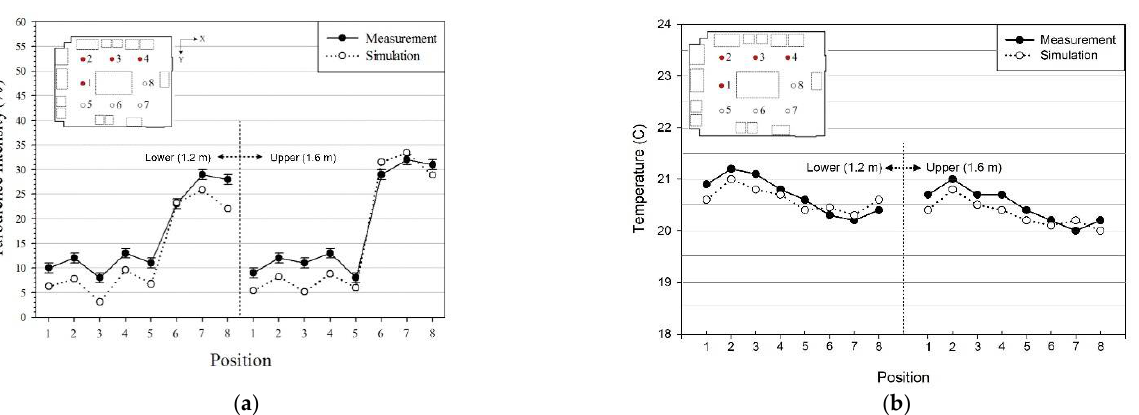
Figure 7. Validation between measurement and simulation: ( a ) turbulent intensity; ( b ) temperature.